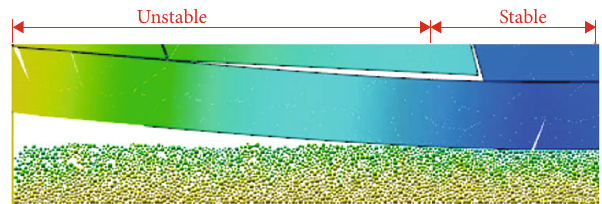
Figure 8: Collaborative support